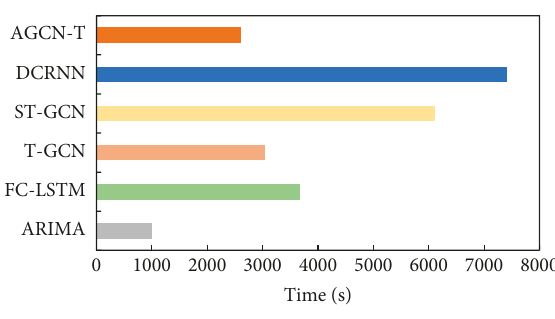
Figure 3: Comparison of